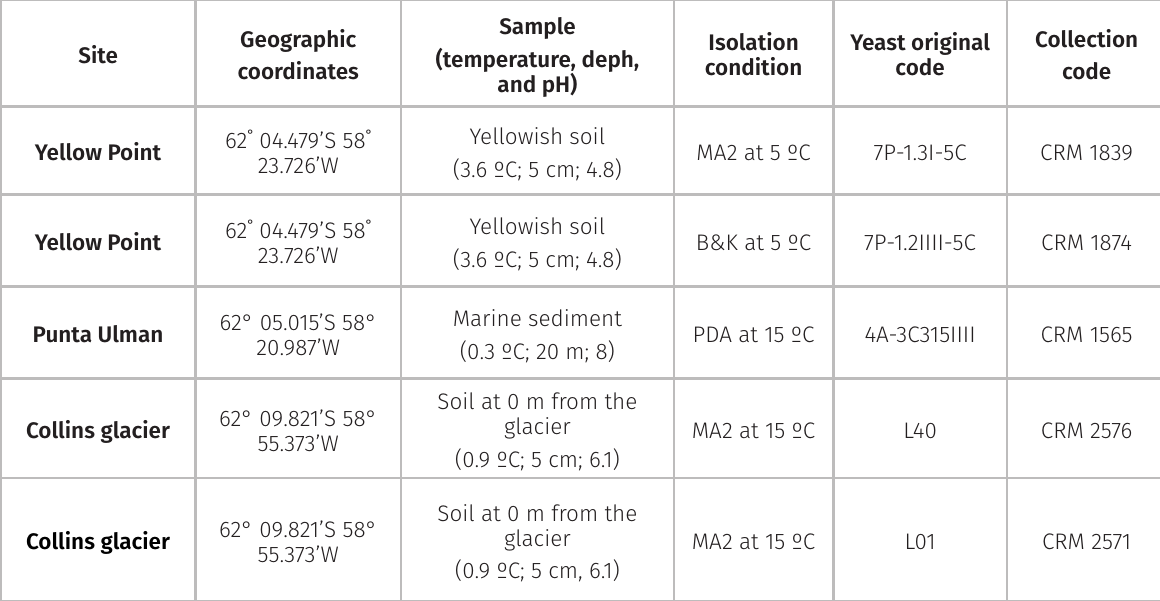
Table I. Data related to the sites, the samples of origin, and yeast isolation conditions and codes. Samplings were performed during OPERANTAR XXXIII (January/February 2015) at King George Island, Antarctic